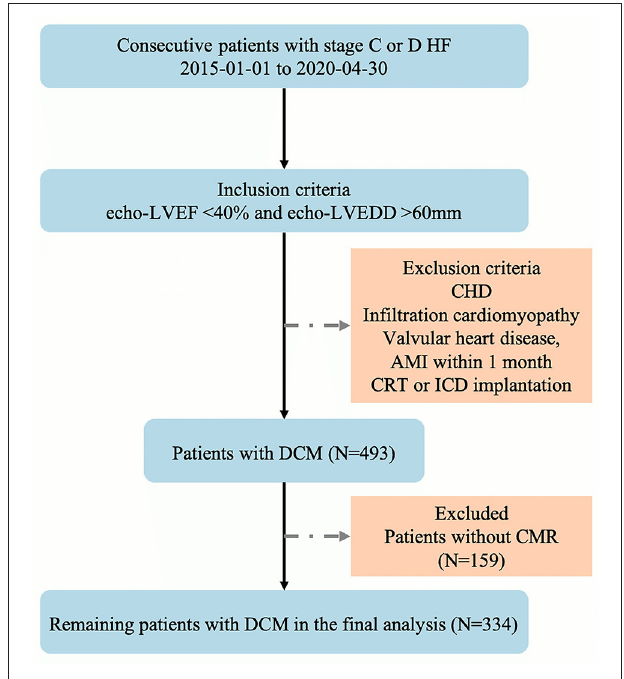
FIGURE 2 | Flow chart of the observational study.